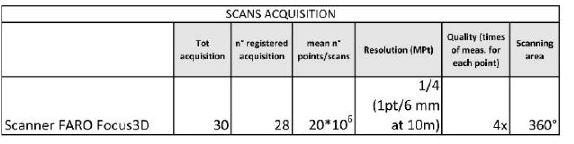
Figure 2. Acquisition parameters of TLS survey